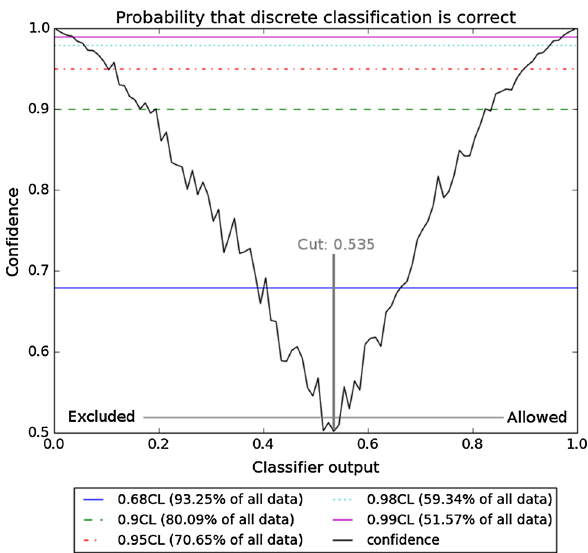
Fig. 3 Confidence level that the classification is correct, as defined in the text. The horizontal lines indicate specific confidence levels